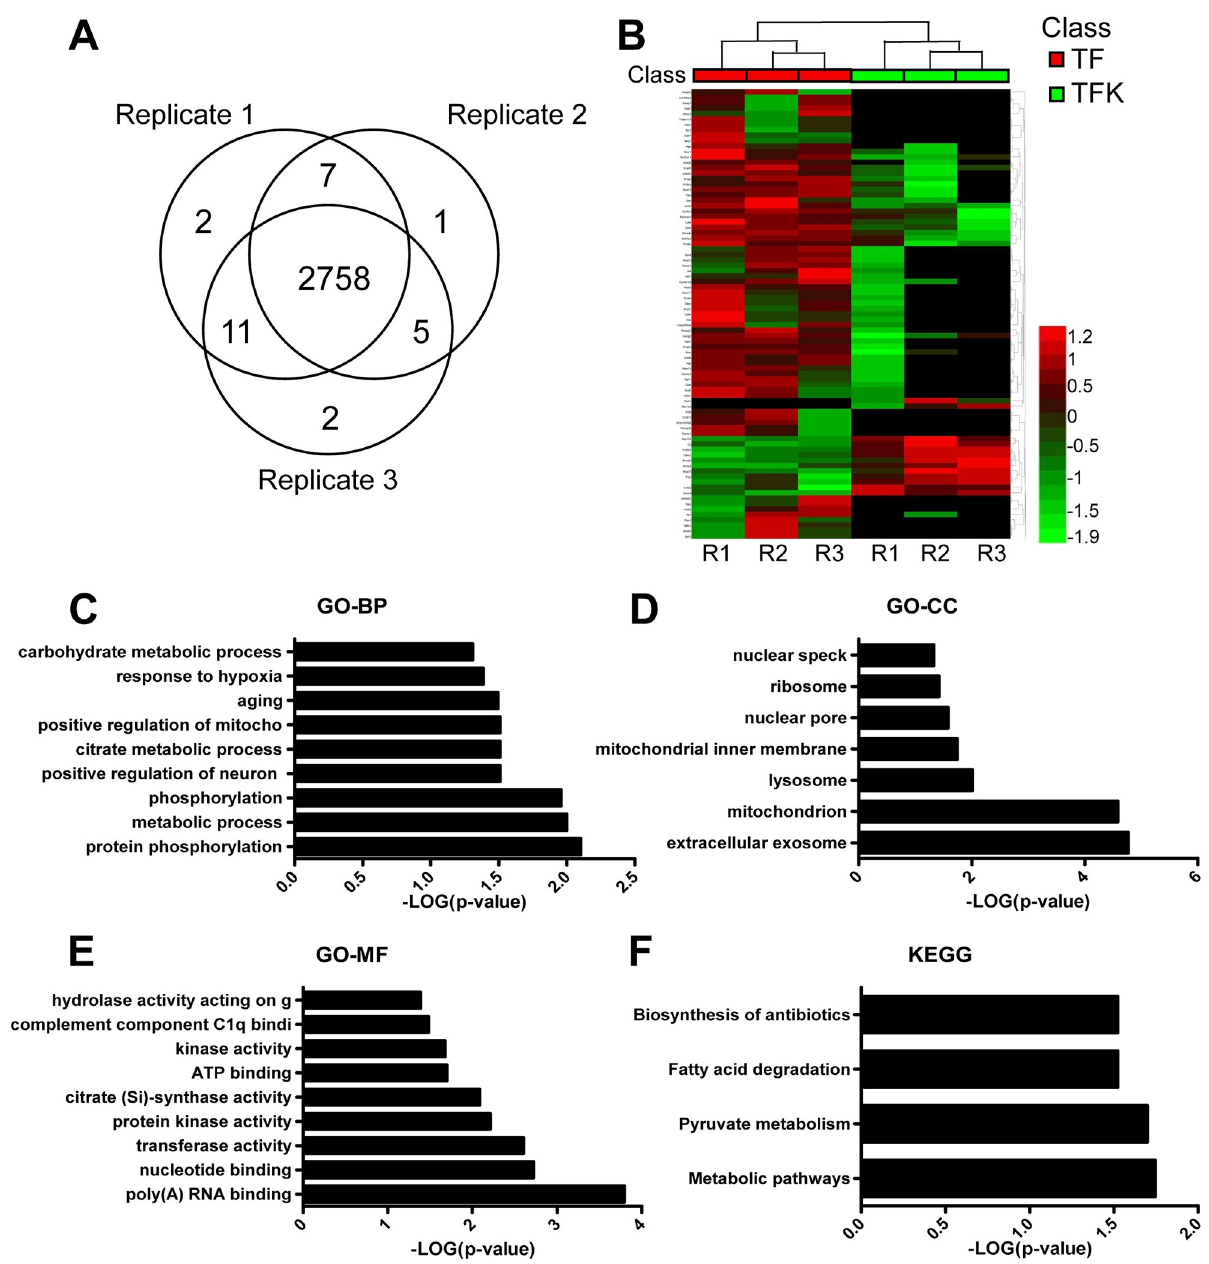
Fig 4. Proteomic study of renal-tubule specific Tmod1 knockout mouse model. (A) Venn diagram of the identified protein numbers in each of the three biological replicates. (B) Heat map of the 83 differentially expressed proteins in TF and TFK mice. The red color indicates high abundance and green color indicates low abundance. (C-F) Functional annotation of 83 differentially expressed proteins by DAVID Bioformatic Resource. Significantly enriched terms of GO_BP (C), GO_CC (D), GO_MF (E), and KEGG pathways (F) were shown.